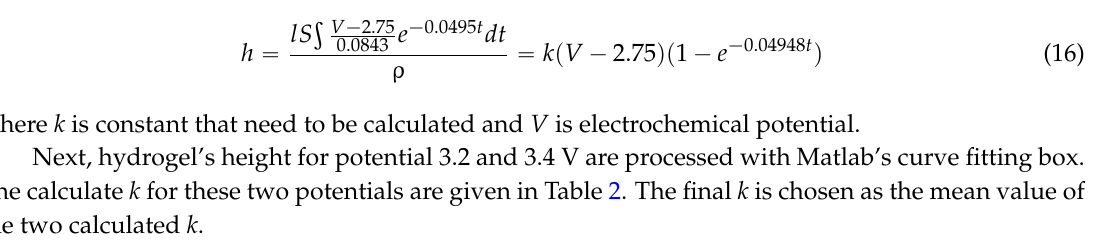
Table 2. Constants computed by experiments with 3.2 V and 3.4 V and final mean value for the constant.